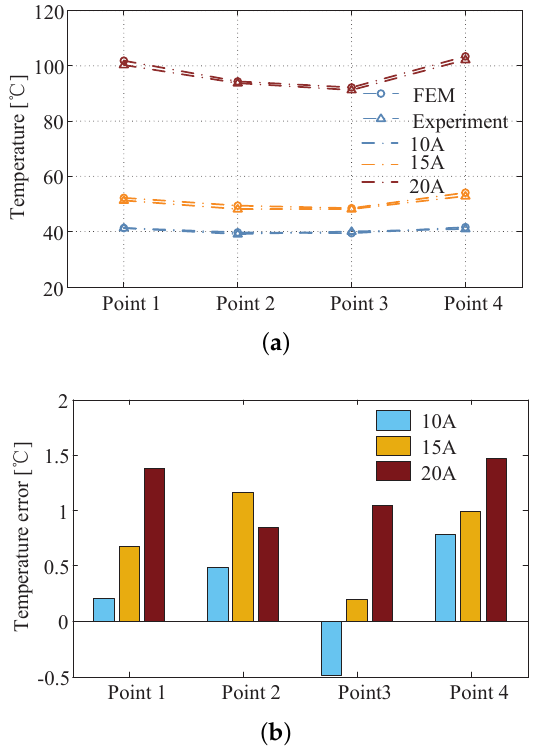
Figure 19. ( a ) Temperature at test points. ( b ) Temperature error at test